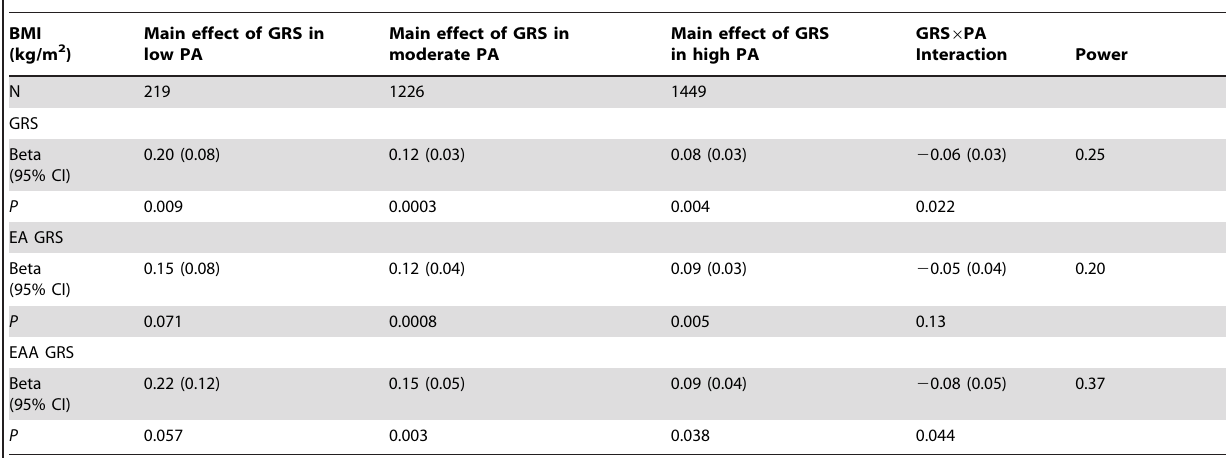
Table 4. Effect of interaction between GRSs and PA on BMI.